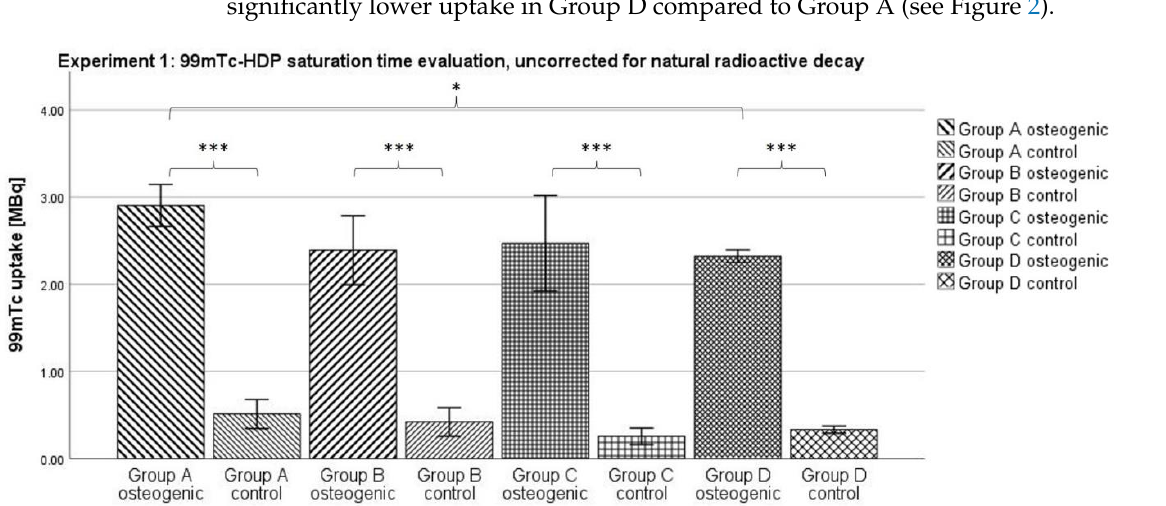
Figure 2. Mean 99m Tc-HDP uptake as measured by the dose calibrator when testing for the saturation time and not correcting for natural radioactive decay. The error bars show the standard deviation.